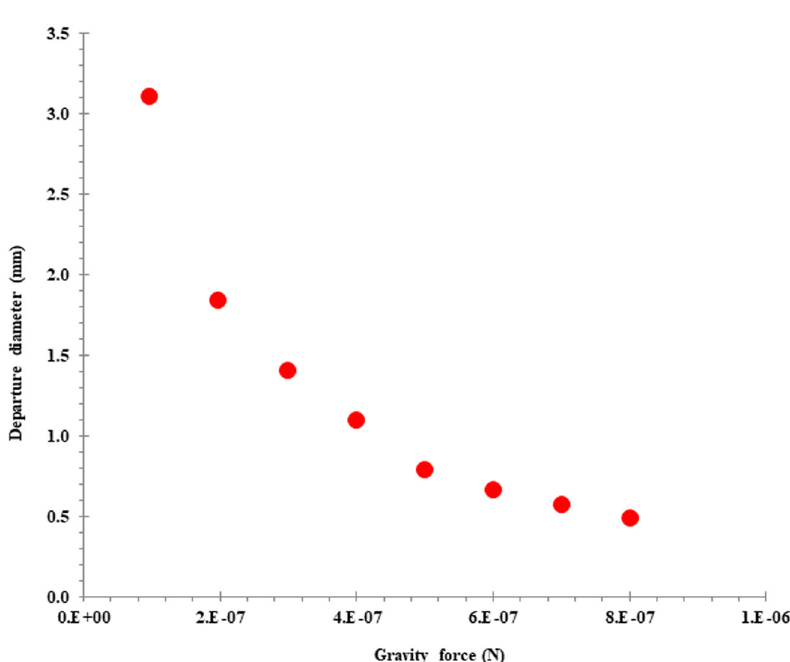
Fig. 9 Effect of gravity force on the bubble departure diameter. The change in bubble diameter with increasing the gravity force from 1e – 7 N to 8e – 7